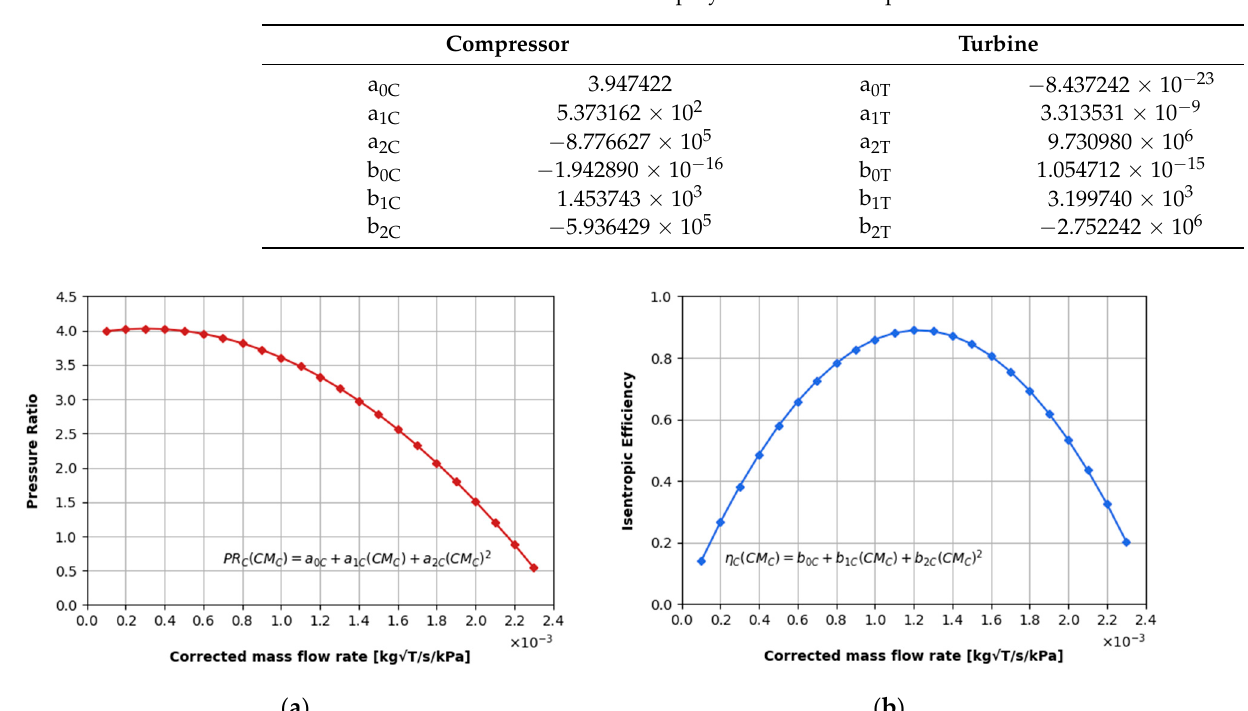
Table 3. Coefficients for the second-order polynomial machine performance curves.